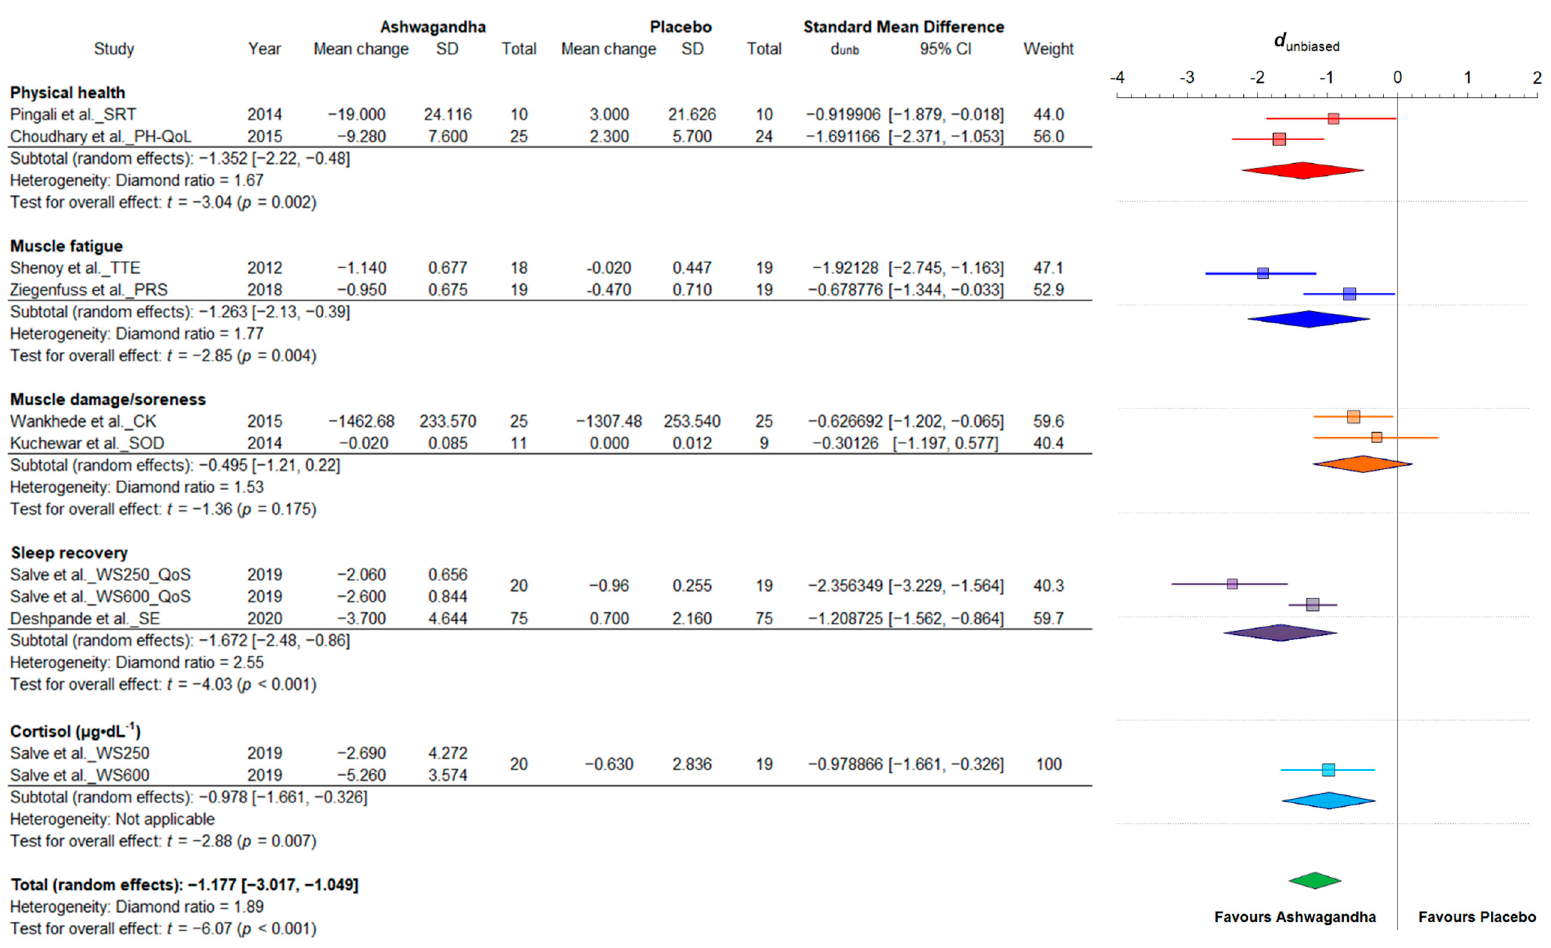
Figure 8. Forest plot depicting the standardized mean differences from the meta-analysis of studies comparing groups with Ashwagandha or placebo on fatigue/recovery. Colored squares represent the d unb for individual trials, while colored and green polygons depict the meta-analytic d unb for the indicated subgroups and for the overall (total) results, respectively. Horizontal lines represent the 95% confidence intervals for the data. SRT: simple reaction time; PH-QoL: physical health component of the quality of life test; TTE: time to exhaustion; PRS: perceived recovery scale; CK: creatine kinase; SOD: superoxide dismutase; SE: sleep efficiency; QoS: quality of sleep; WS250: Withania somnifera 250 mg; WS600: Withania somnifera 600 mg.